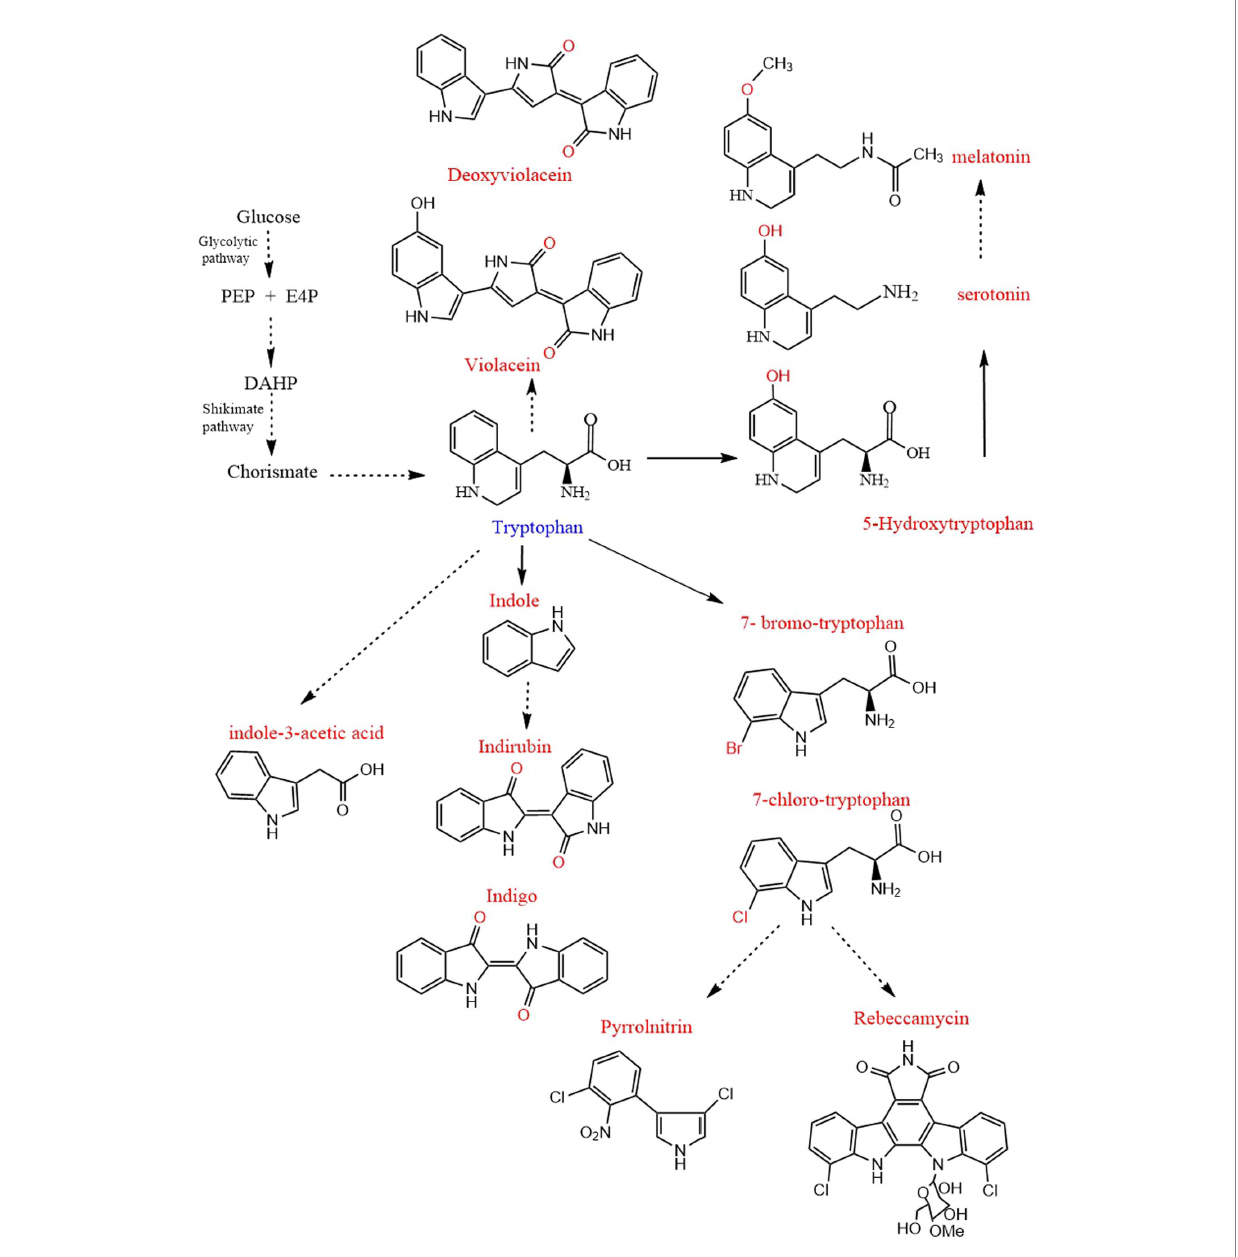
FIGURE 2 Biosynthesis pathway of tryptophan derivatives. PEP, Phosphoenolpyruvate; E4P, D-erythrose 4-phosphate; DAHP, 3-deoxy-D-arabino-heptulosonate- 7-phosphate. The straight line and dotted line represent one-step and multi-step,